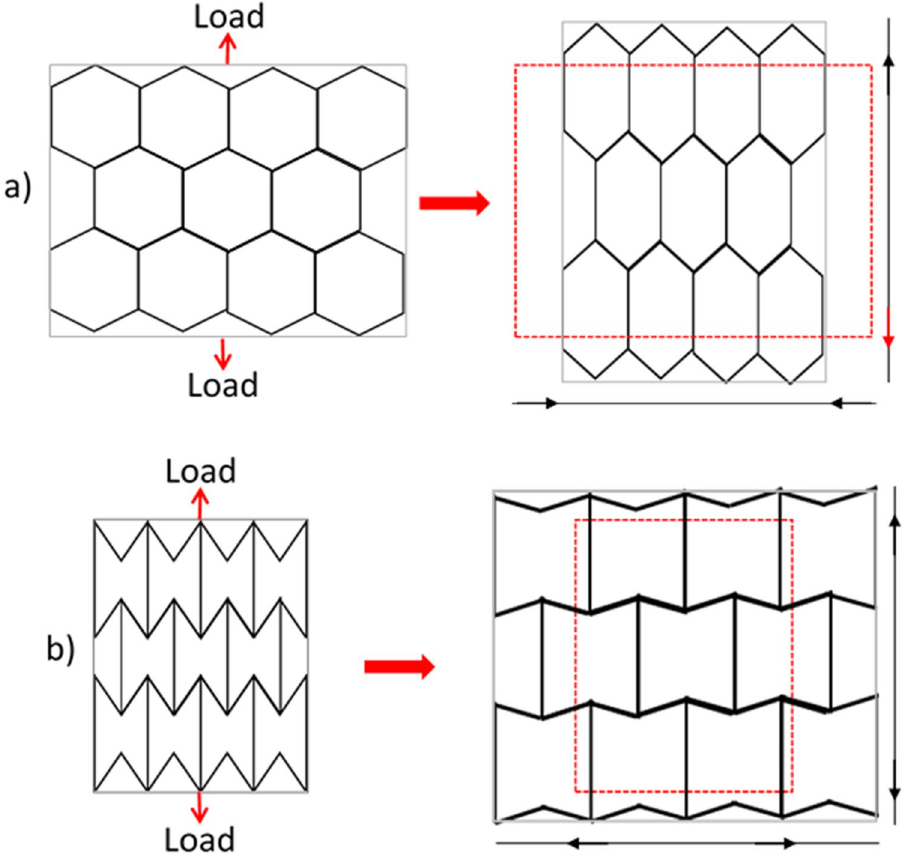
Figure 1. Conventional honeycomb ( a ) and auxetic ( b ) structures under